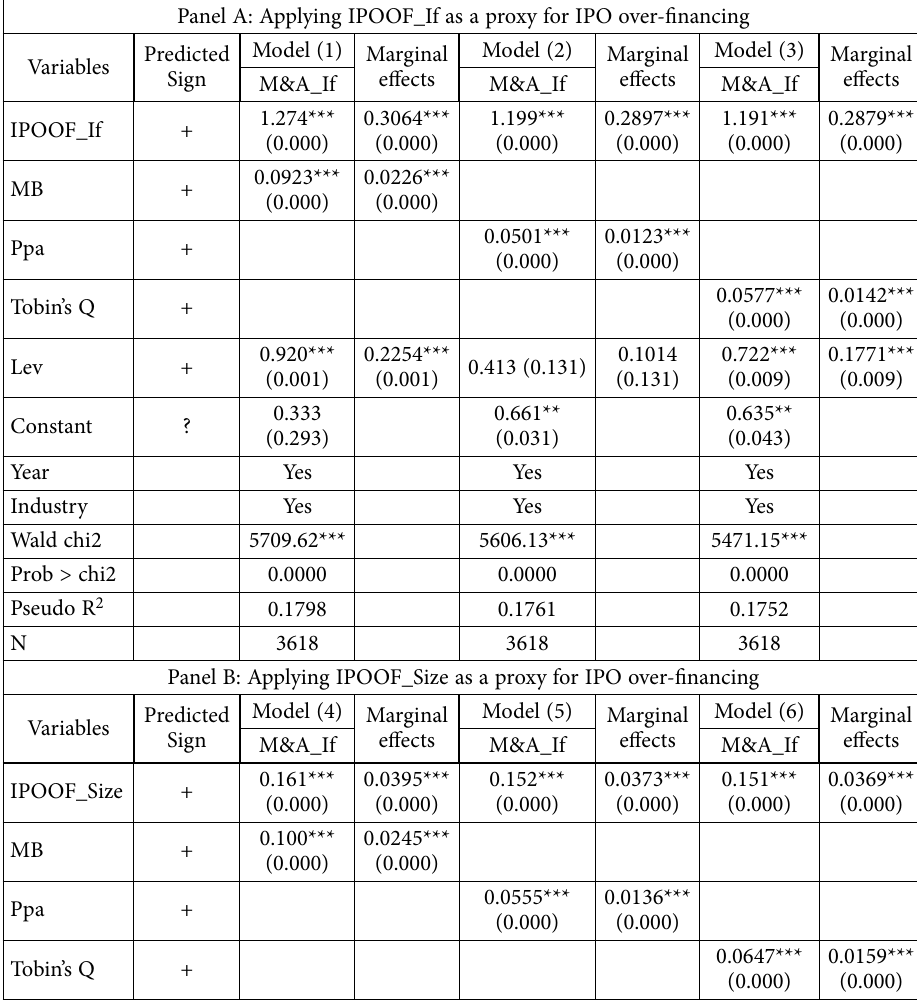
Table 10. IPO Over-financing, market overvaluation and acquisition probability Panel A: Applying IPOOF_If as a proxy for IPO